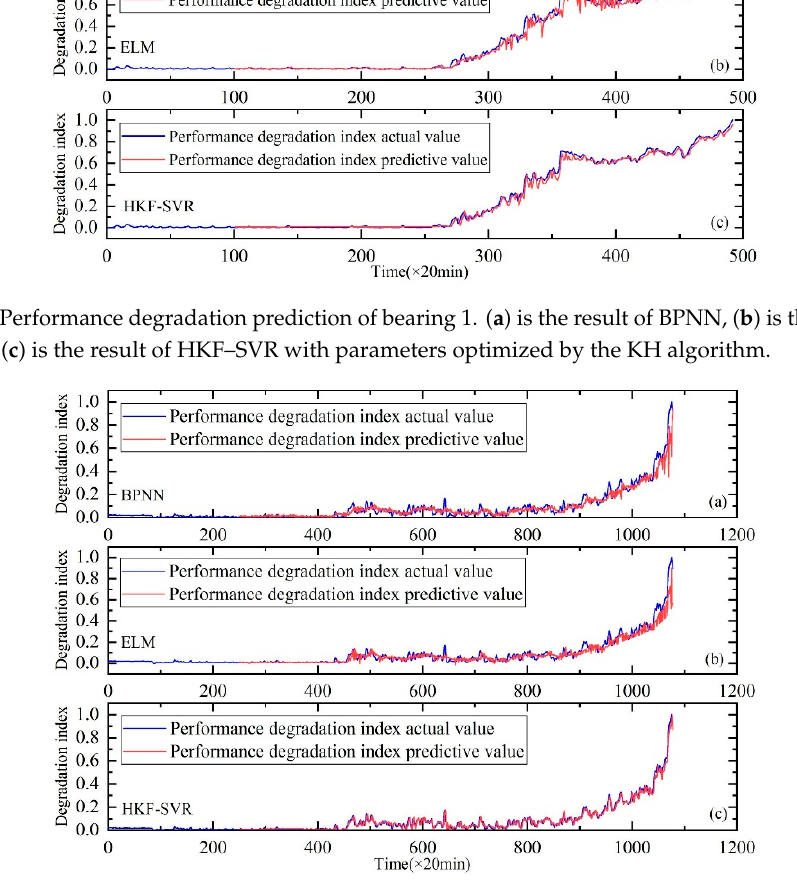
Figure 9. Performance degradation prediction of bearing 3. ( a ) is the result of BPNN, ( b ) is the result of ELM and ( c ) is the result of HKF–SVR with parameters optimized by the KH algorithm. Table 5. Prediction errors